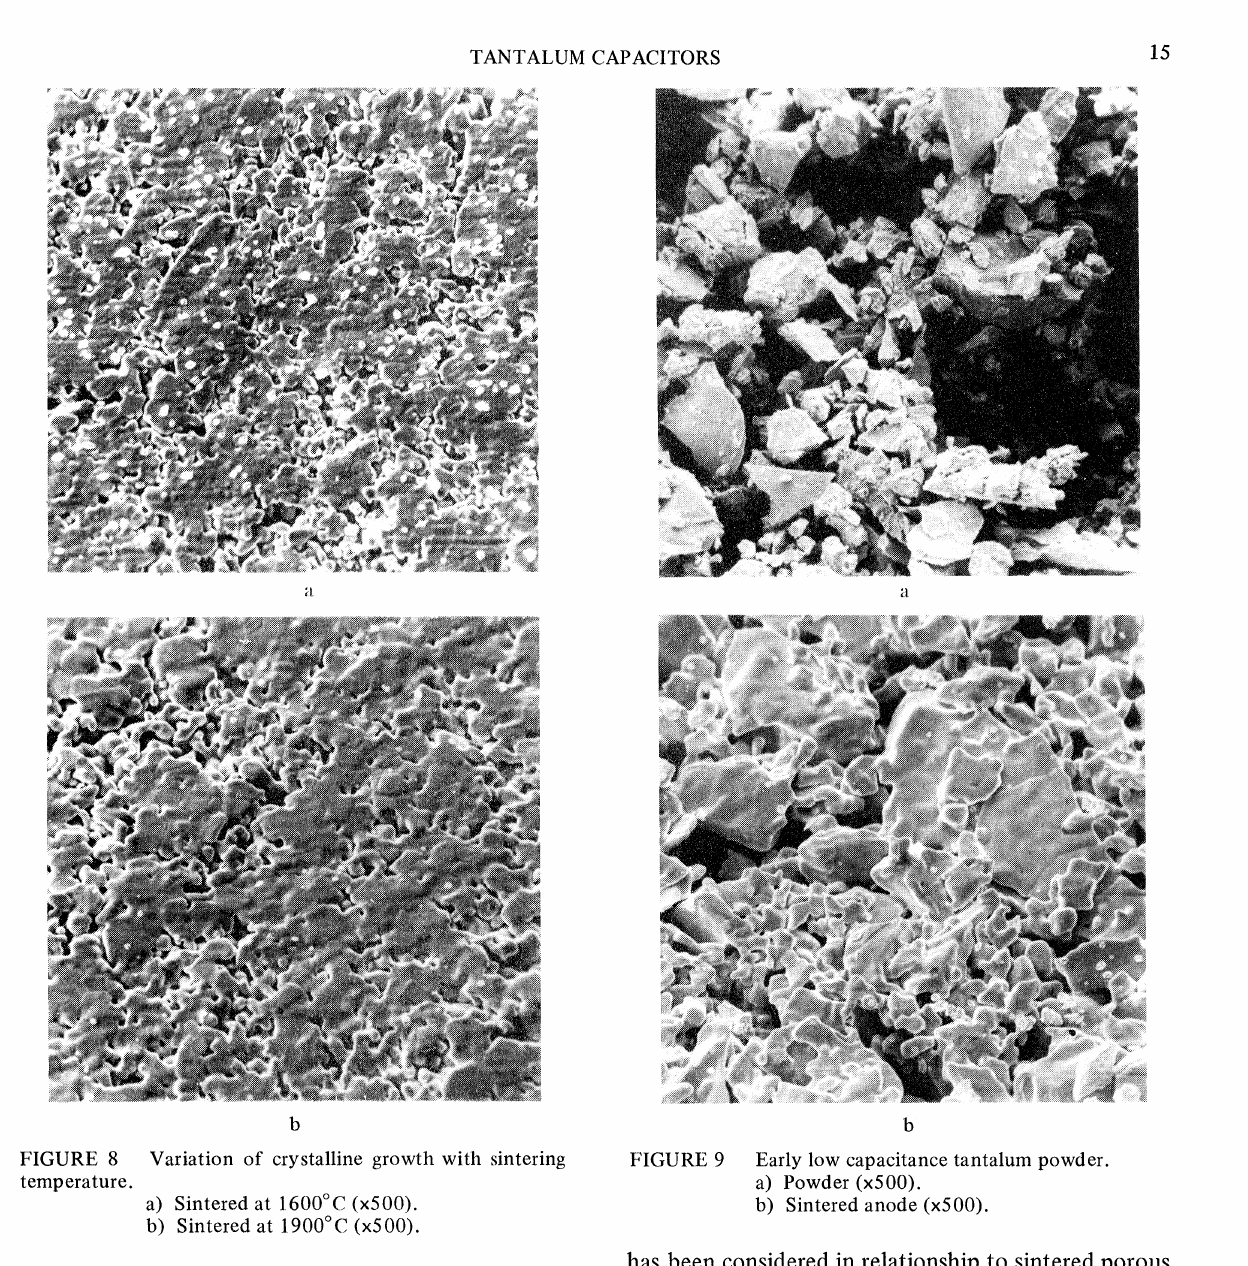
b FIGURE 9 Early low capacitance tantalum powder. a) Powder (xS00). b) Sintered anode